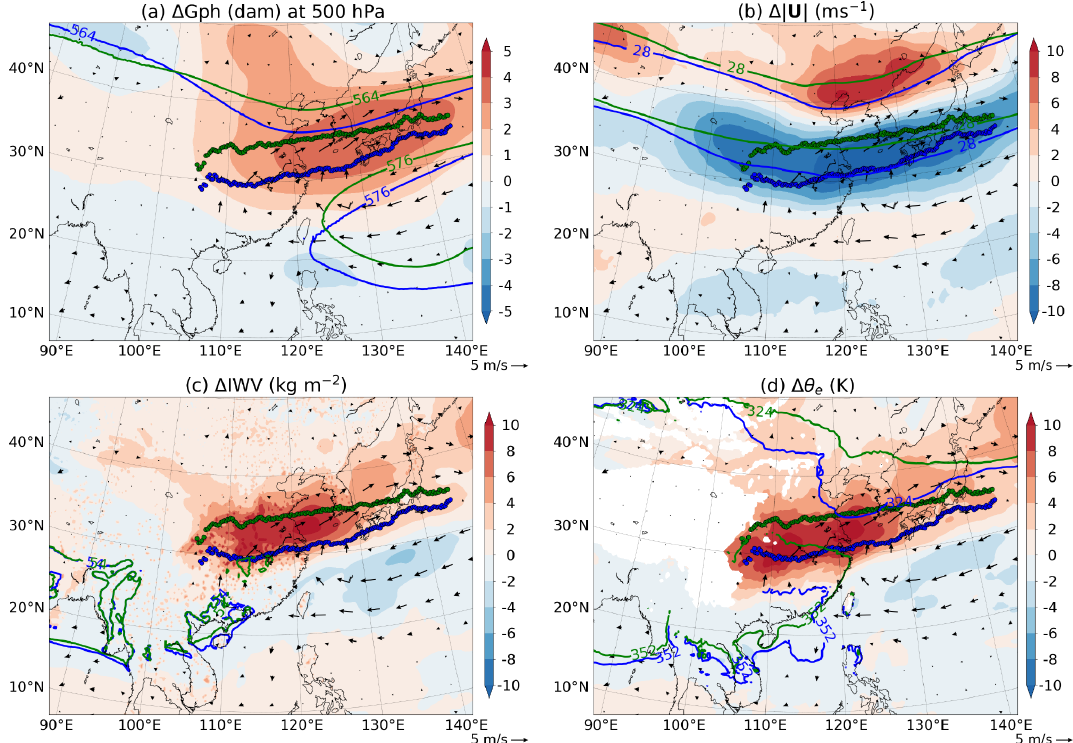
Figure 15. High-lat year − low-lat year anomalies of wind vectors at 850hPa (arrows; ms − 1 ) and of (a) geopotential height at 500hPa (shading; dam), (b) wind speed at 200hPa (shading; ms − 1 ), (c) 500–1000hPa IWV (shading; kgm − 2 ), and (d) equivalent potential temper- ature at 850hPa (shading; K). Selected values of high-lat and low-lat year composites are indicated separately by green and blue contours, respectively. The contours displayed, indicating the same field the anomalies refer to in each panel, are (a) 564 and 576dam, (b) 28ms − 1 , (c) 54kgm − 2 , and (d) 324K at 700hPa and 352K at 925hPa. The EASMF is indicated in all panels by bold green and blue lines for high-lat years and low-lat years, respectively. All panels refer to the third dekad of June, selected in Fig. 3 to represent the Mei Yu stage. All values are masked out at levels below the ground. Data from ERA5 1979–2018